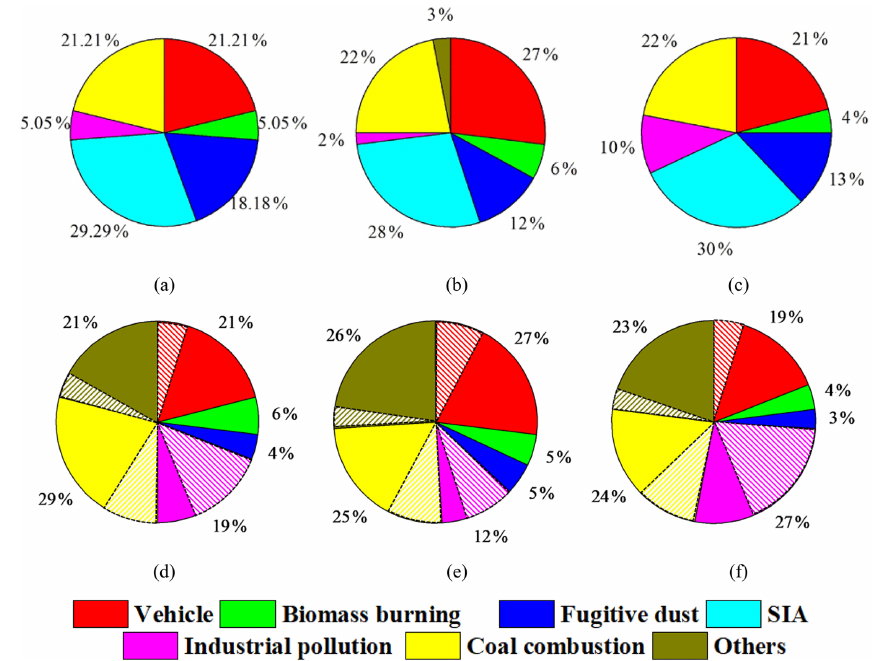
Figure 7. Source apportionment of accumulation mode particles at NJU (a) , PAES (b) and NUIST (c) and source apportionment of light scattering for accumulation mode particles at NJU (d) , PAES (e) and NUIST (f) . The shadow represents the contribution of secondary aerosols from each source category. Table 3. The source contributions of secondary aerosols to aerosol light scattering at the three sites for the clean and polluted periods